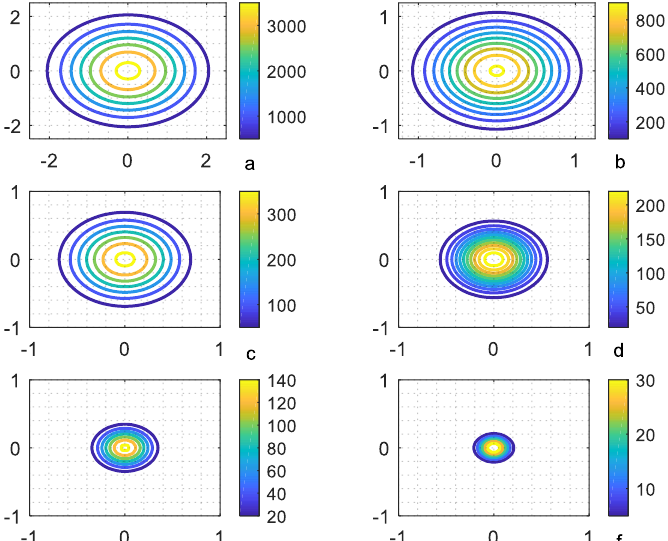
Figure 7: Contour plots of Antenna temperature (T ) due to observing the frequency (v = A 1.42 GHz), a – Antenna diameter (D = 1 m), b – Antenna diameter (D = 2 m), c – Antenna diameter (D = 3 m), d – Antenna diameter (D = 4 m), e – Antenna diameter (D = 5 m), and f – Antenna diameter (D = 10 m).